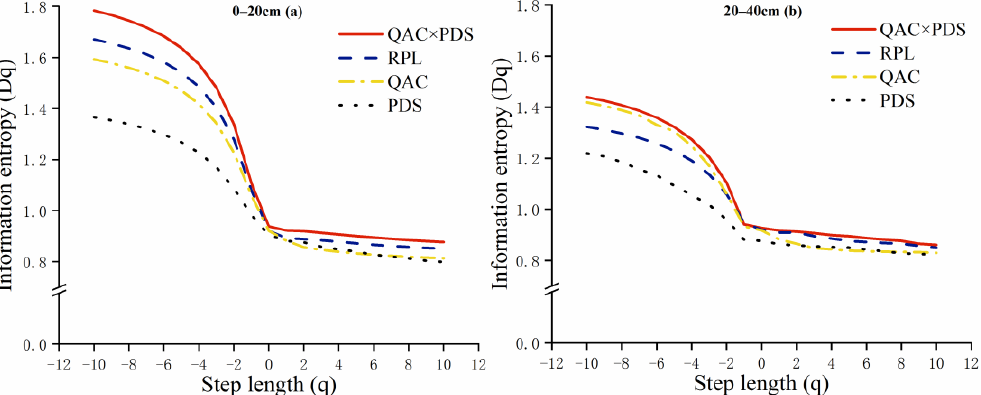
Figure 5. Multi-fractal R é nyi spectra D ( q) − q curves of four vegetation restoration types. ( a ) repre- sents the frequency curves of soil particles of 0–20 cm soil layer, ( b ) represents the frequency curves of soil particles of 20–40 cm soil layer.